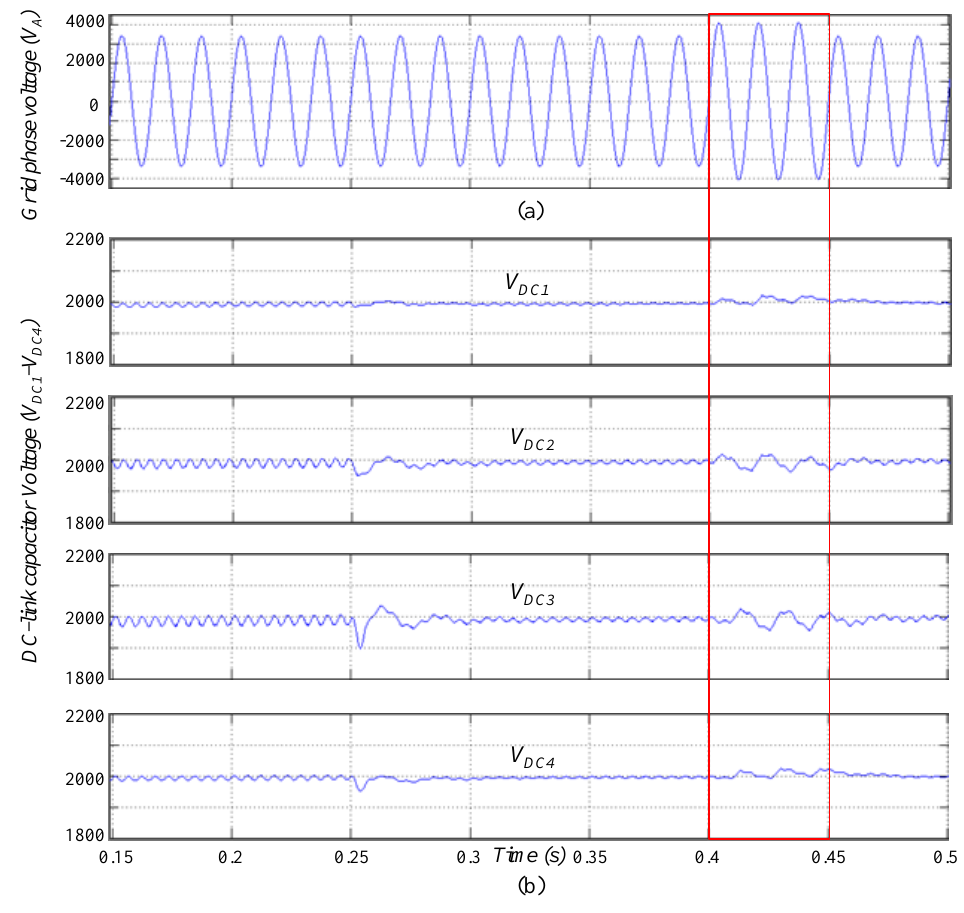
Figure 13. Simulation waveforms of the proposed five-level STATCOM under voltage swell condition. ( a ) Phase output voltage ( V AN ) for Phase A; ( b ) DC-link capacitor voltages ( V DC 1 - V DC 4 ).